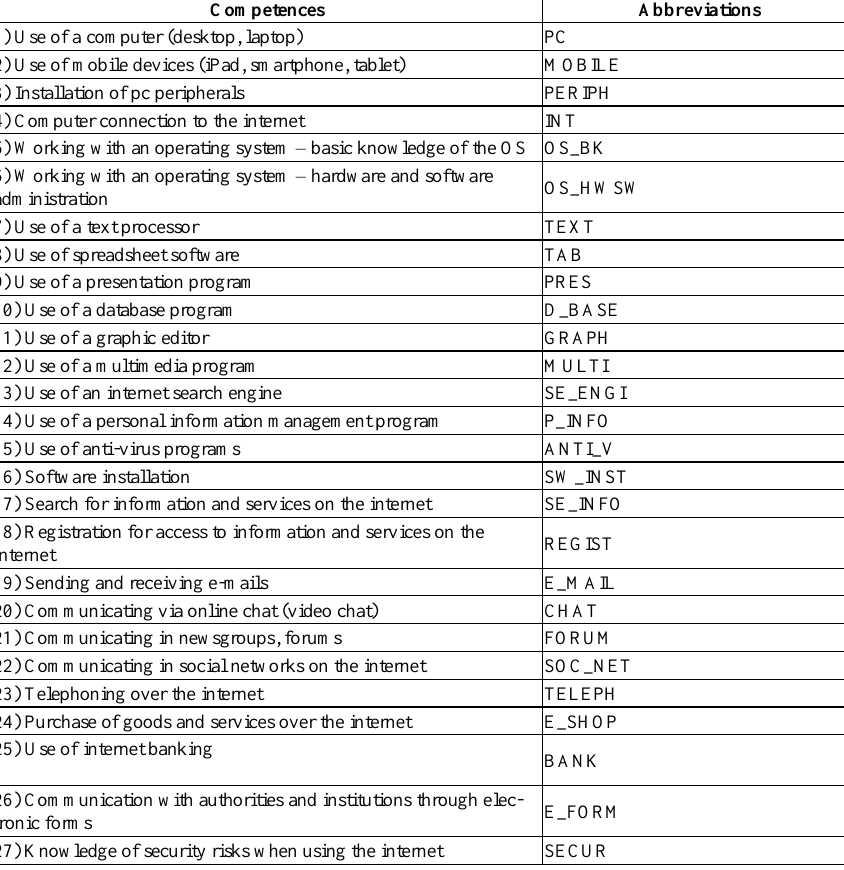
Table 4. The examined competences of digital literacy and their